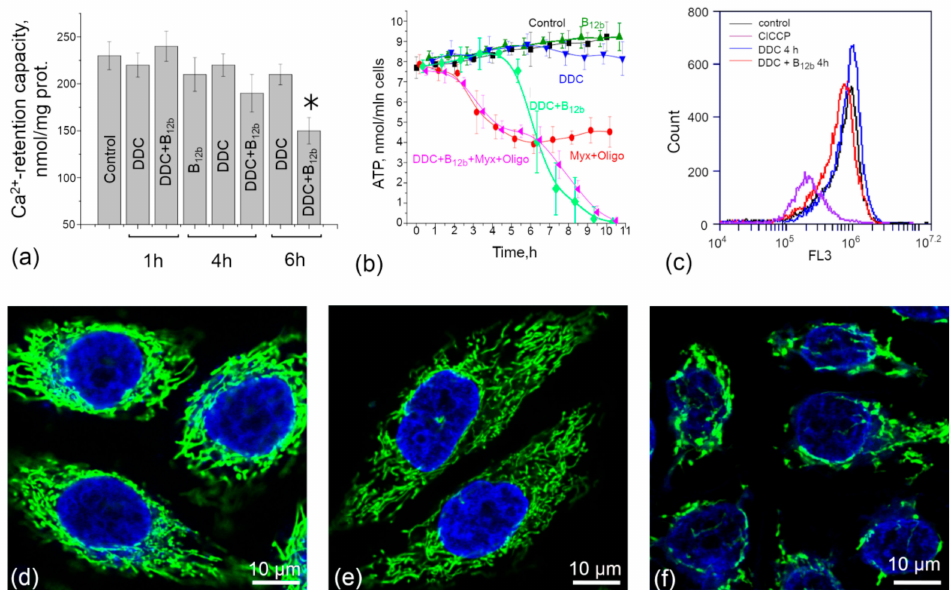
Figure 8. E ff ect of 1 mM DDC and 25 µ M B 12b alone and of their combination on the indicators of mitochondrial activity: ( a ) capability of mitochondria to accumulate Ca 2 + in permeabilized cells; ( b ) the amount of intracellular ATP; ( c ) membrane mitochondrial potential evaluated by flow cytometry of cells loaded with 10 nM DiOC6(3); ( d – f ) confocal microscopy images of HEp-2 cells loaded with H342 (1 µ g / mL) and 10 nM DiOC6(3); ( d ) control (untreated) cells; ( e ) cells after 4-h incubation with DDC; and ( f ) cells after 4-h incubation with DDC + B 12b . The concentrations of myxothiazol (Myx) and oligomycin (Oligo) were 20 and 10 µ M, respectively. *, di ff erences between the sample and the control are significant, p <